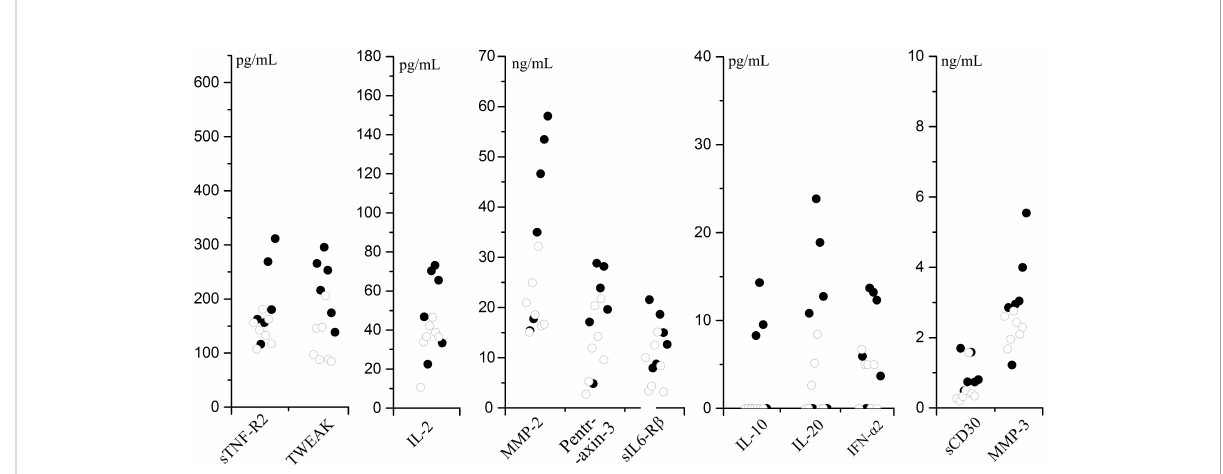
FIGURE 8 Cytokines that negative correlate to the application of bronchial lavage (p < 0.1) in SMPP